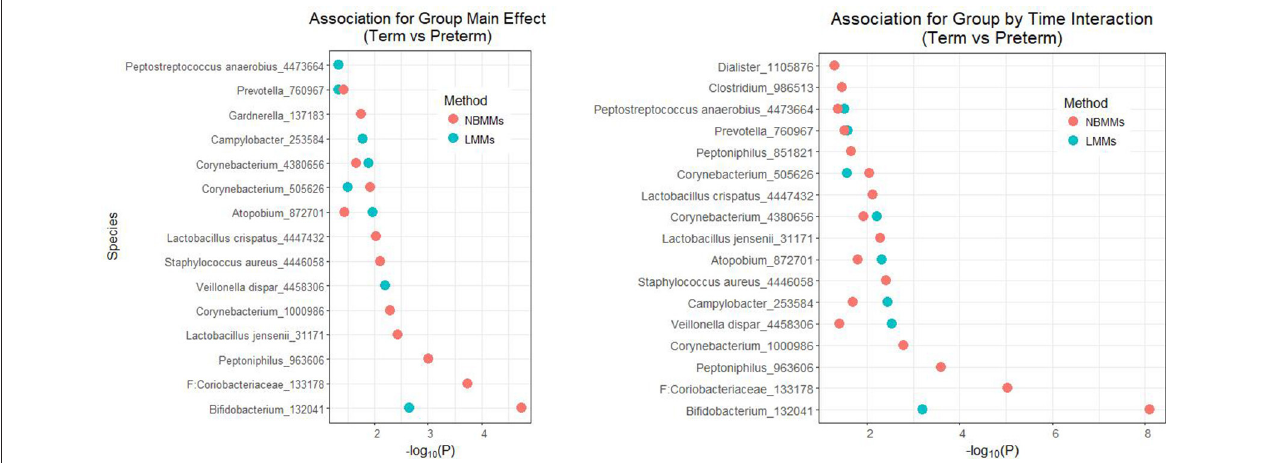
FIGURE 4 | The analyses of NBMMs and LMM: minus log transformed p -values for the significant differentially abundant taxa at the 5% significance threshold between term and preterm groups for species level; the left panel shows the minus log transformed p -values for association of group main effect, and the right panel shows the minus log transformed p -values for association for group by time